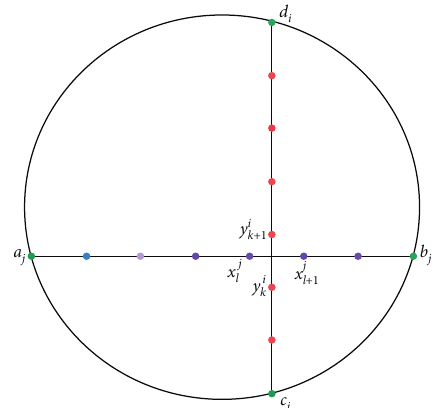
Figure 3: Example of horizontal and vertical segments and the repartition of internal nodes.